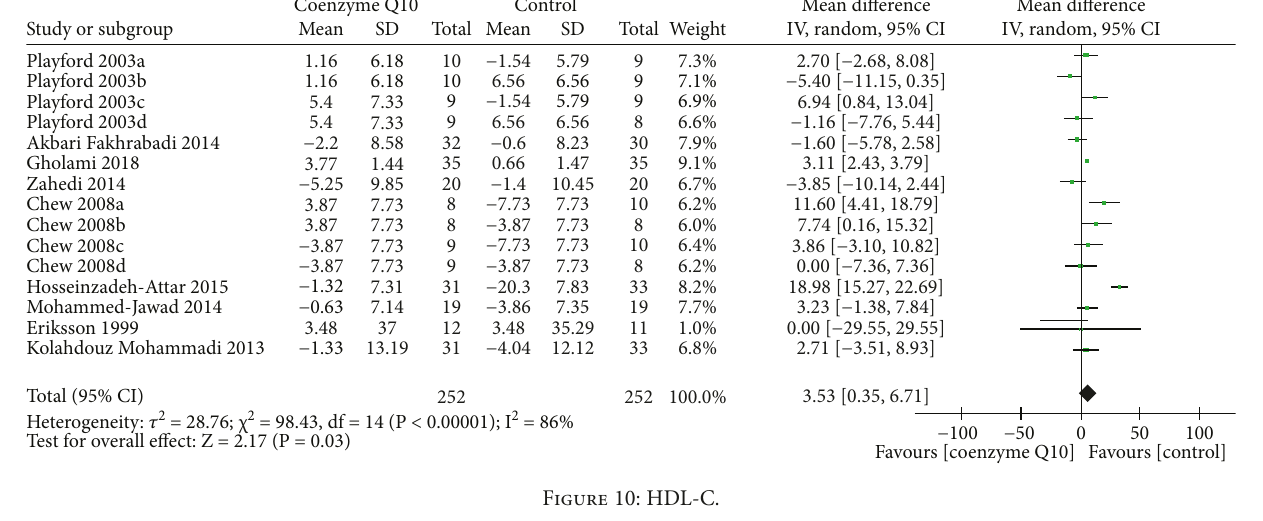
Figure 10: HDL-C.